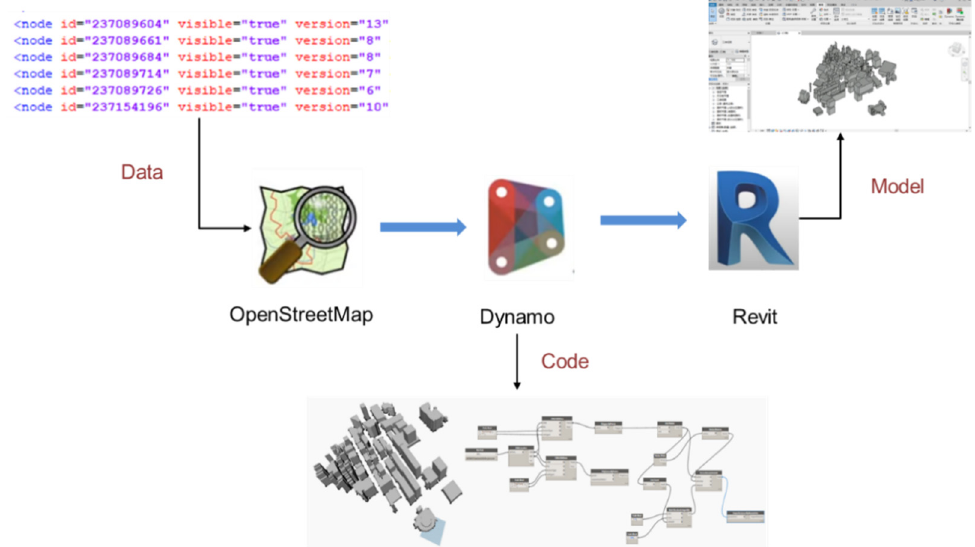
Figure 3. Generation method of architectural scene.